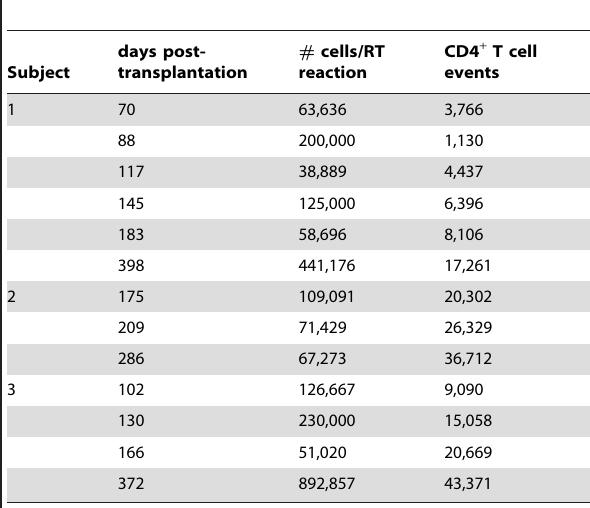
Table 1. Sample sizes for the biological assays used to collect data on the three DiGeorge